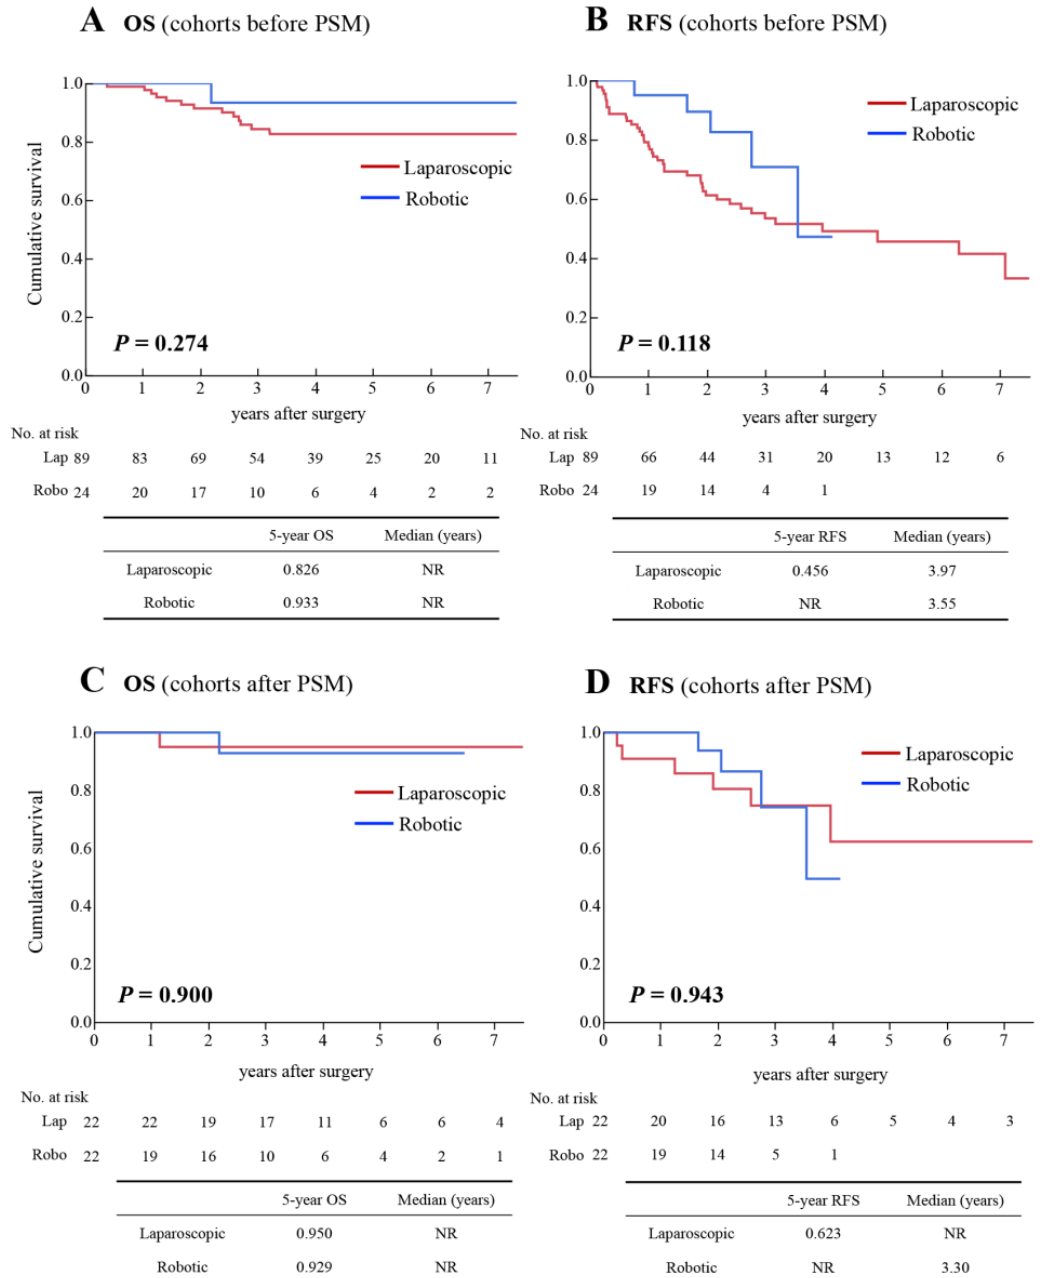
Figure 3. Overall (OS) and recurrence-free (RFS) survivals after laparoscopic and robotic anatomic resection: ( A ) OS in the unmatched cohorts; ( B ) RFS in the unmatched cohorts; ( C ) OS in the matched cohorts; ( D ) RFS in the matched cohorts; NR: not reached.